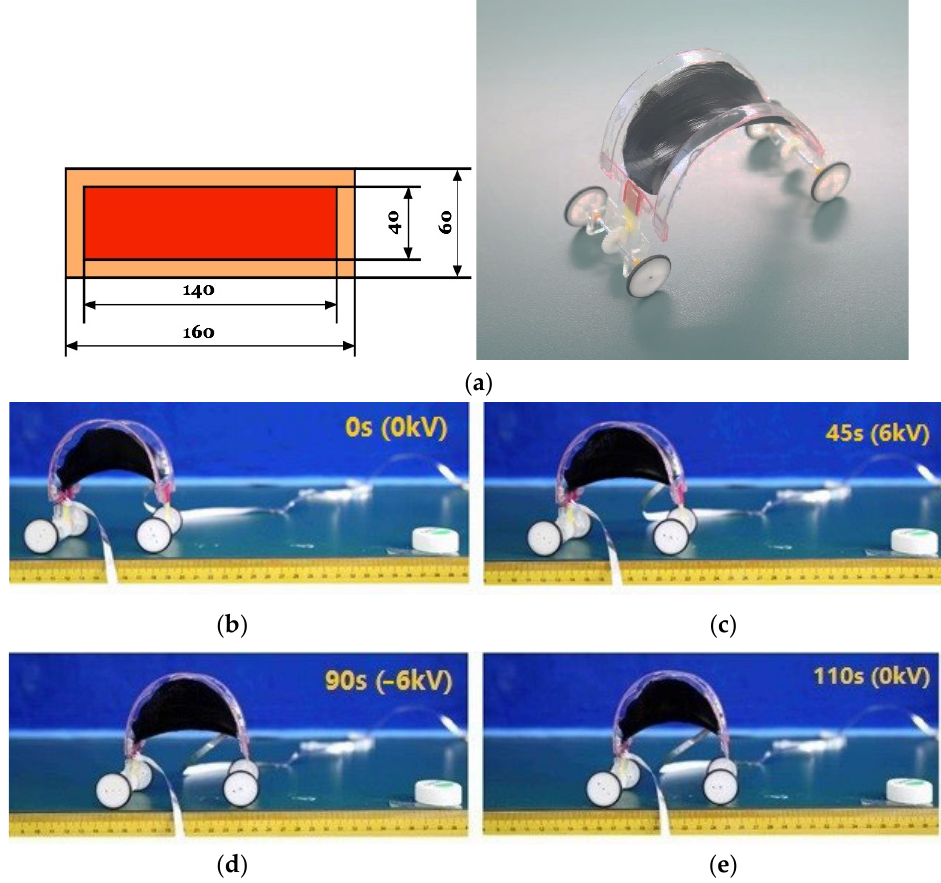
Figure 4. Design and experiment of a soft machine enabled by the combination of soft DEMES and hard ratchet-wheels. ( a ) Planar view and as-fabricated state of the DEMES. ( b – e ) A series of still frames from the experimental video shows the locomotion of the soft machine.